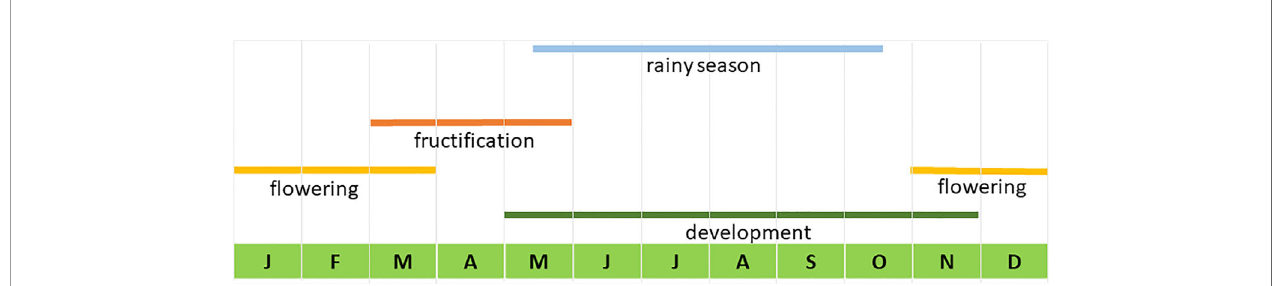
FIGURE 1 | Temporal phenology of Agave inaequidens in the study area. Modi fi ed from Leo ́ n,